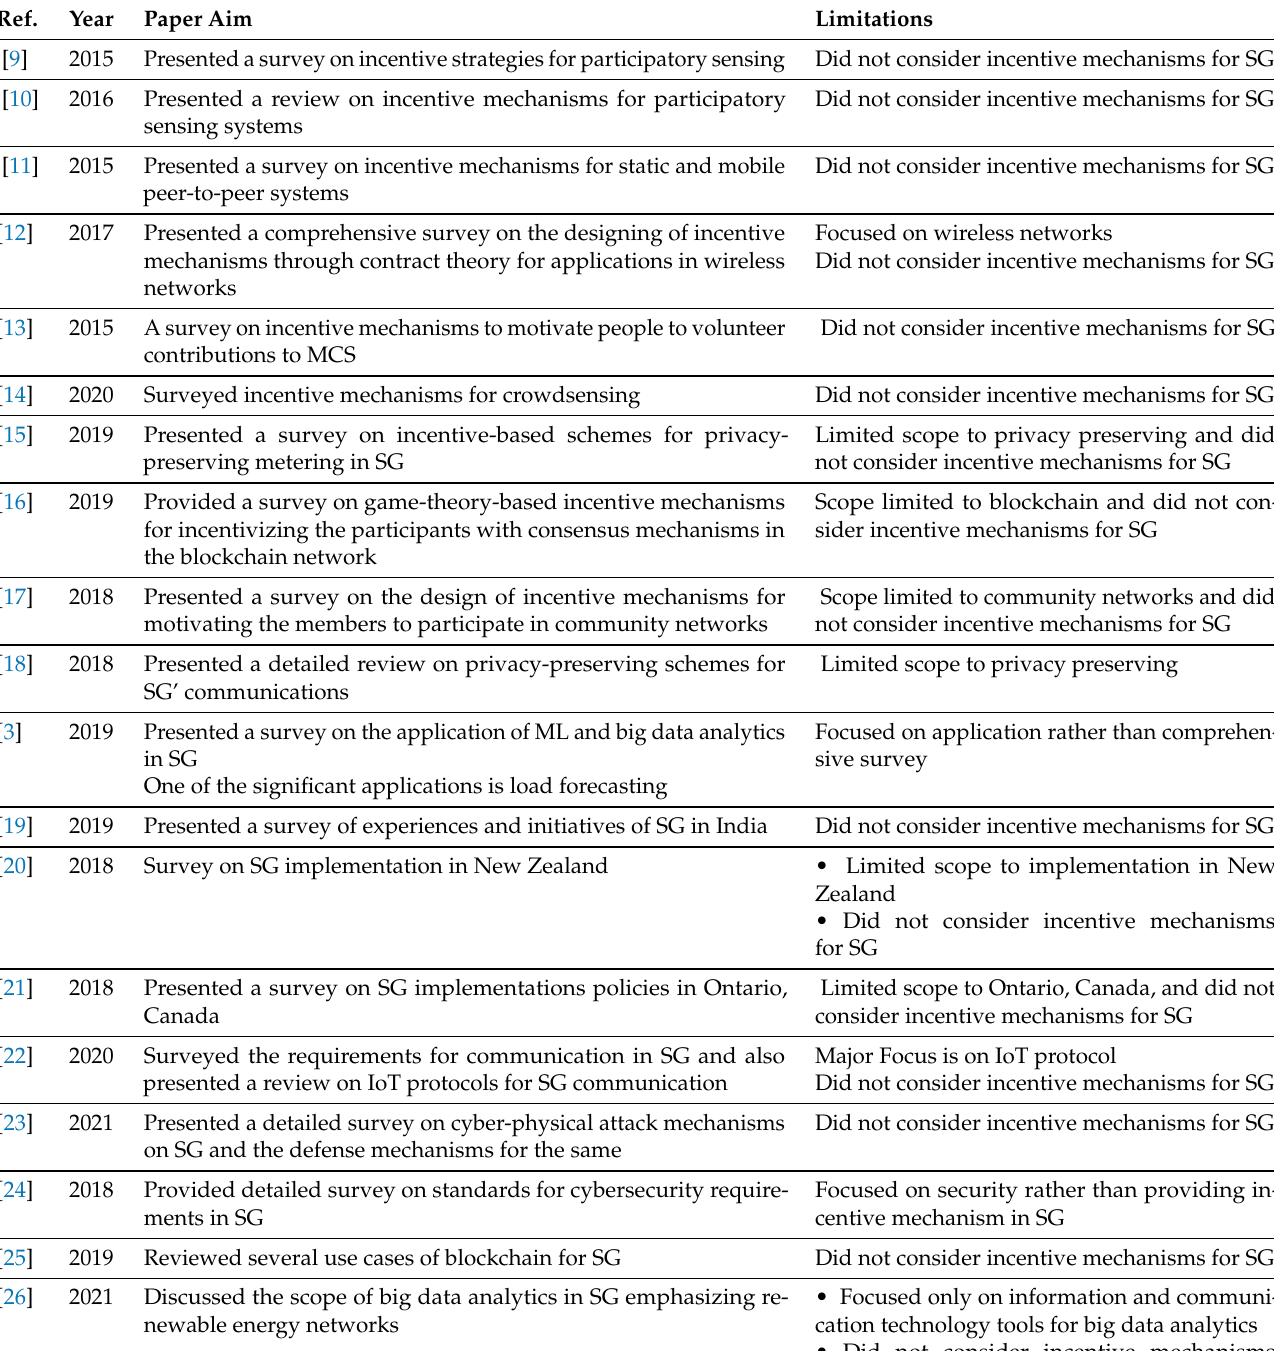
Table 1. Summary of existing